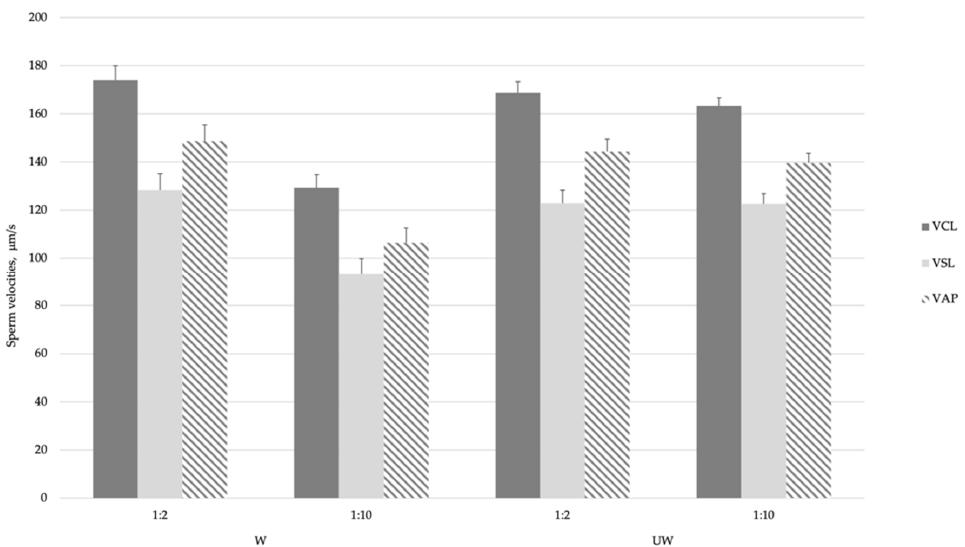
Figure 2. Effect of dilution and washing (washed: W vs. not washed: UW) on velocities (VLC, VSL and VAP) of goat spermatozoa after liquid storage.